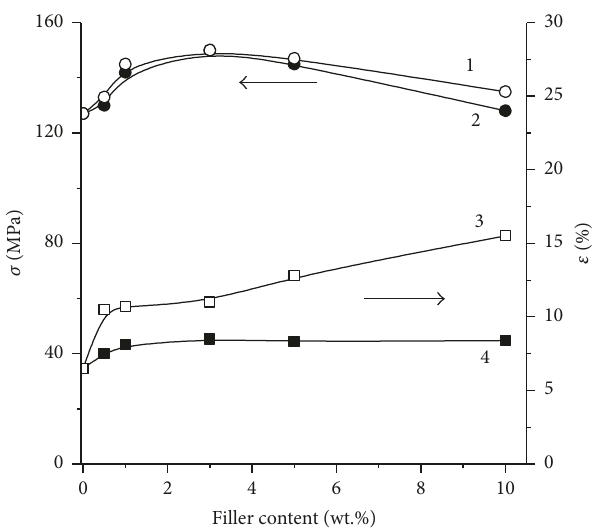
Figure 8: Concentration dependence of the tensile strength (1 , 2) and the breaking elongation (3 , 4) for HEC/bentonite (solid symbols) and HEC/organobentonite (open symbols) composite films.